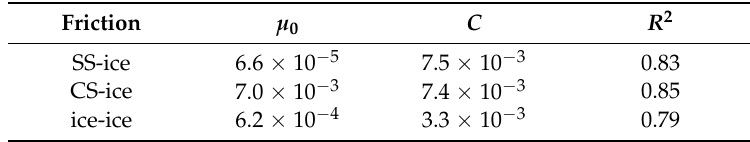
Table 2. Empirical constants μ 0 and C and coefficient of determination R 2 of each contact fitted by the Equation (4) with significance less than 0.05.